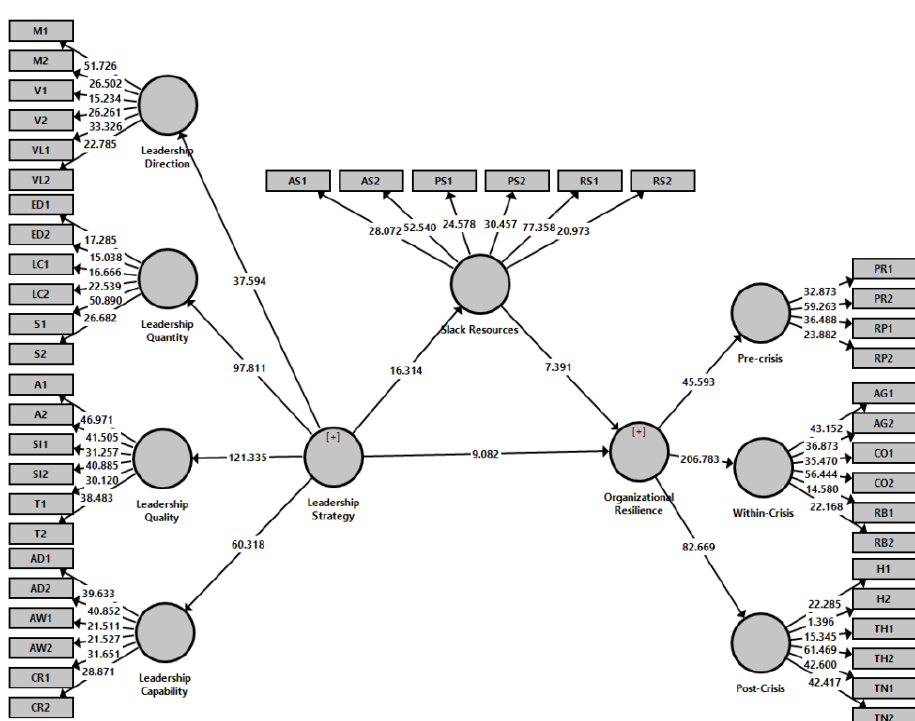
Figure 2: Model Path Coefficients of Slack Resources